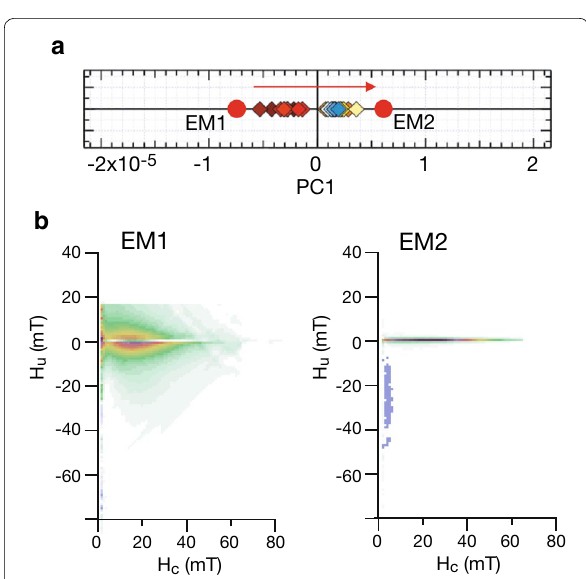
Fig. 8 FORC-PCA results for samples from IODP Hole U1365A, South Pacific Ocean. a Distribution of 30 FORC data (squares) in PC1 space with two-endmembers (EM1 and EM2). The arrow indicates the general downcore trend. b FORC diagrams for EM1 and